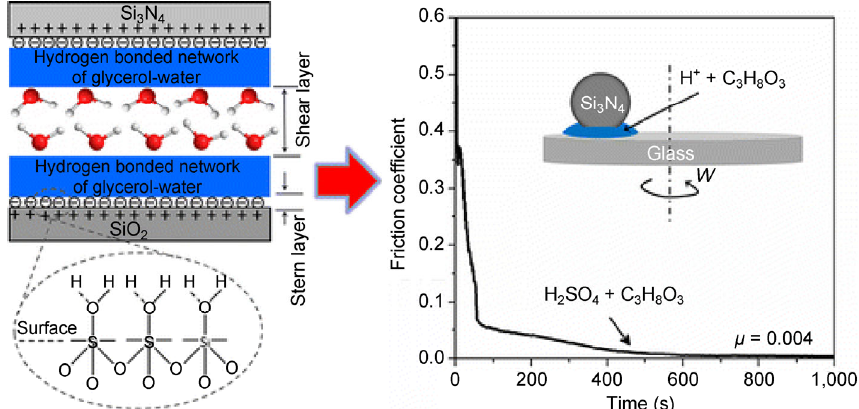
Fig. 26 Superlubricity achieved with mixtures of acids and glycerol reported by Li et al. [135]. Copyright 2013, American Chemical